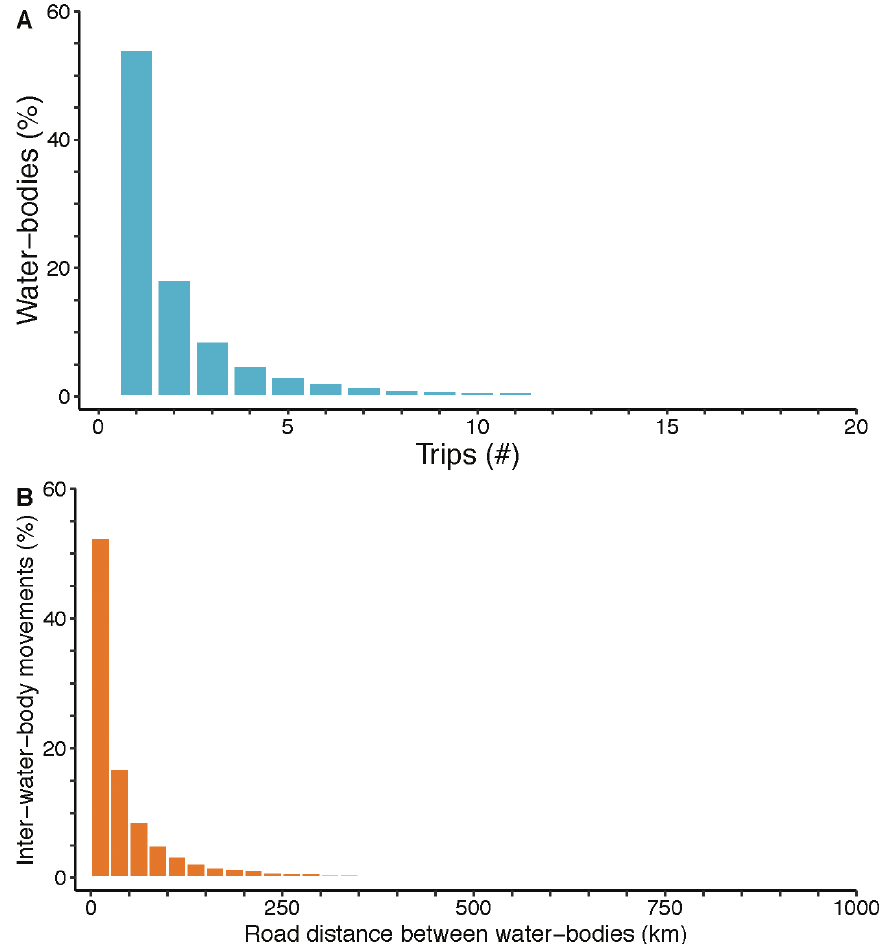
Figure 2. A Percentage of water-bodies according to the number of trips taken by iBobber users, trun- cated at 20 trips (bin size = 1) and B the frequency (%) of movements between two subsequently visited water-bodies by road distance (km) (bin size = 25), truncated at 1,000